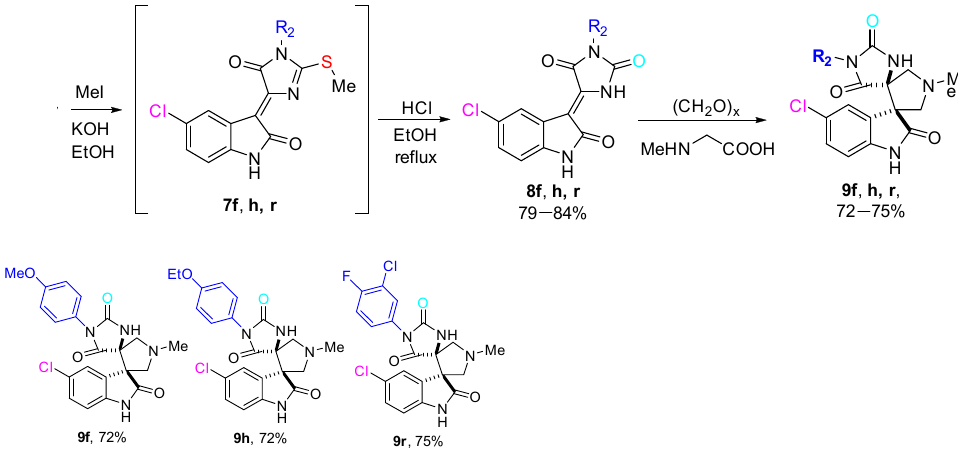
Scheme 4 . Synthesis of O-containing analogue of the compounds 4 .